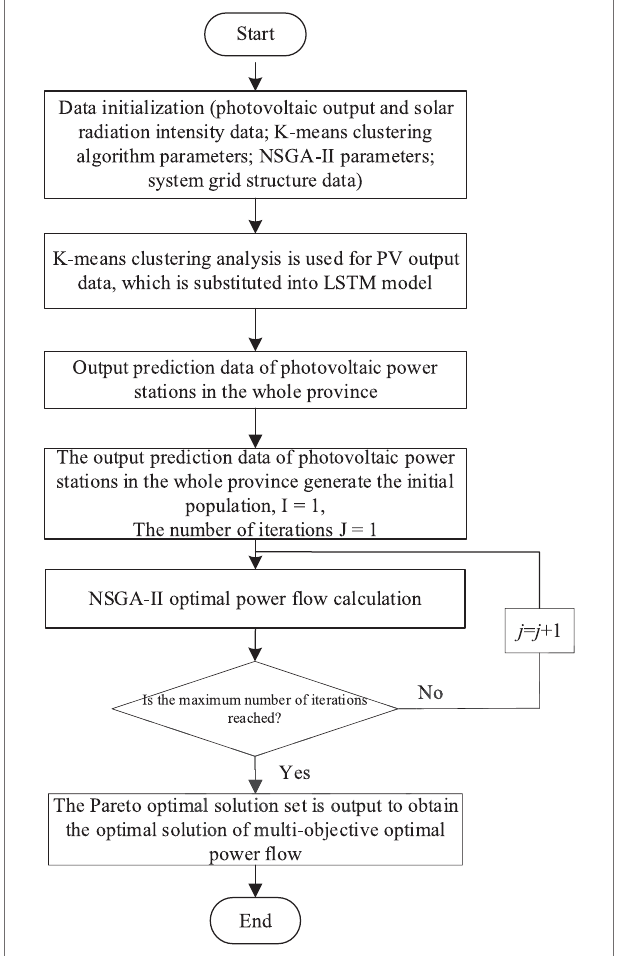
FIGURE 3 | Flow chart of optimal power fl ow considering large-scale photovoltaic.